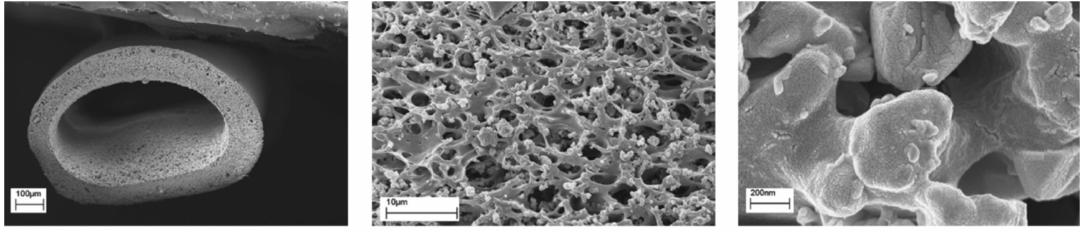
Figure 11. SEM images at di ff erent magnifications. The left hand side image shows the porous polyester urethane / zeolite fiber. The middle image reveals the zeolite crystal dispersion in the polymer fiber. The right hand side image with high magnification reveals the zeolite clusters. Reprinted with permission from [91]. Copyright © 2010 American Chemical